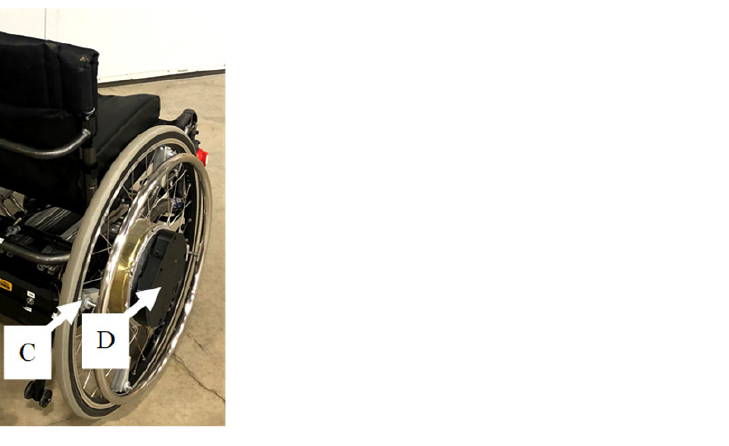
Figure 1. BCIT Wheelchair. A: In-hub Motor; B: Microcontroller, motor controller, IMU (frame), batteries; C: Force sensor; D: Microcontroller, IMU (wheels), batteries. Table 1. Technical specification for the BCIT wheelchair.